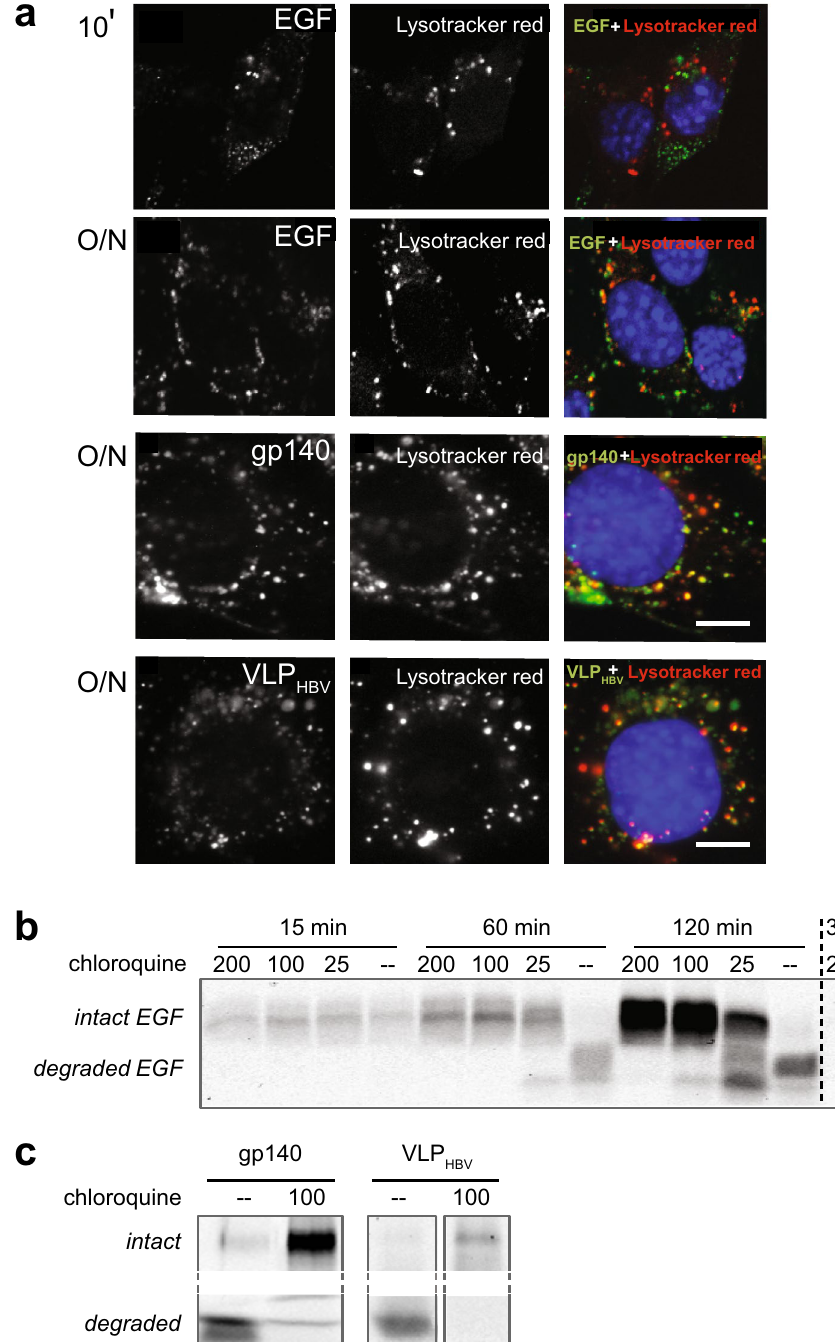
Figure 3. Bispecific VHH mediated recruitment results in lysosomal degradation. ( a ) Colocalization of Alexa- 488 fluorescently labeled EGF, gp140 and VLP (green) with lysotracker red in EGFR expressing cells. EGF was bound for 10 min and overnight, viral proteins were internalized overnight, mediated by bispecific VHHs H2E1 and Hep1E1 resp. Nuclei are blue, scale bar: 5 µm. n = 2, representative experiment shown. ( b ) Chloroquine inhibits EGF degradation. SDS-PAGE gel of IR800 labelled EGF in cells. EGF was incubated on cells after 60 min pretreatment with chloroquine (µM indicated). Cells were lysed, run on SDS-PAGE gel and IR800 was detected. n = 2, representative experiment shown. ( c ) Similarly, chloroquine inhibits gp140 and VLP HBV degradation. SDS- PAGE gel of IR800 labelled gp140 and VLP HBV internalized in cells after treatment with or without chloroquine (100 μM). Intact and degraded are in the same lane in the gel. n = 2, representative experiment